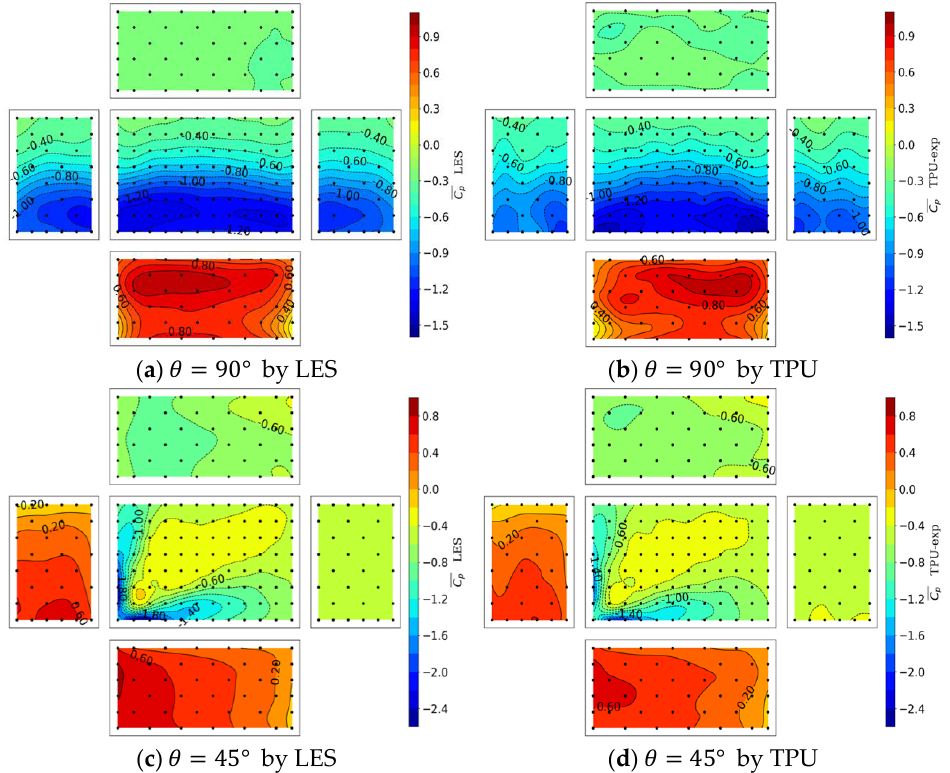
Figure 12. The time-average surface pressure coefficient on an isolated low-rise building by LES (left side) and by TPU (right side). side) and by TPU (right